Question: Looking at the figure, what chart type is it?
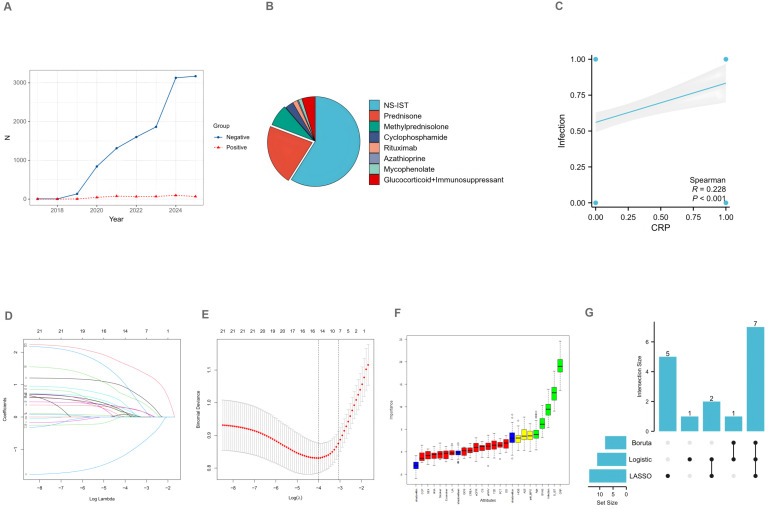
Answer: line